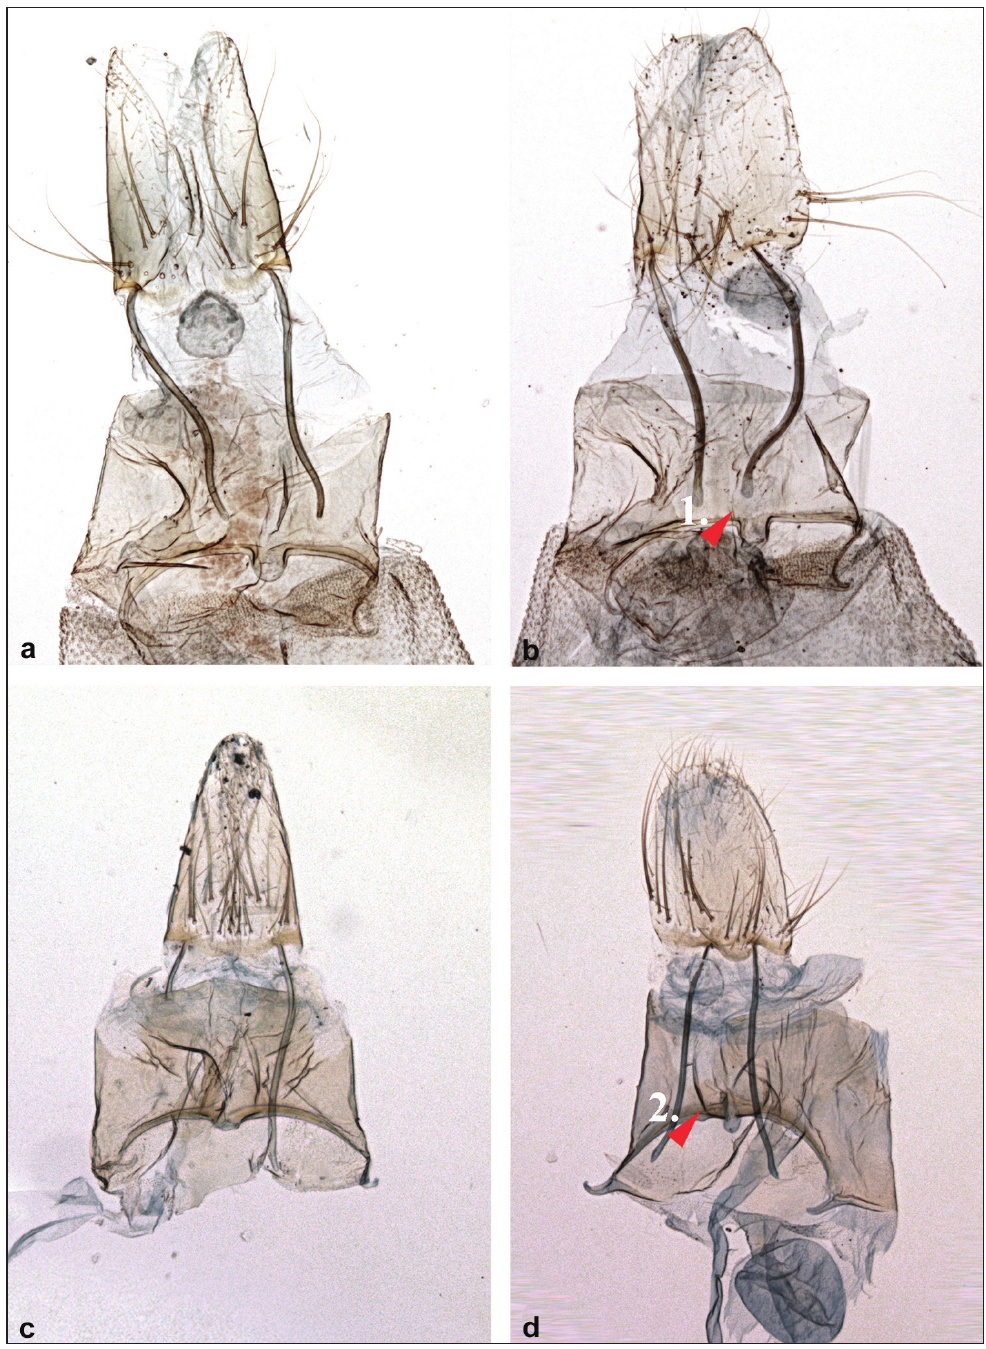
Figure 9. Anarsia female genitalia. a, b. A. innoxiella sp. n. (KG3368, KG3360); c, d. A. lineatella (KG3335, KG3341). 1. ridges absent; 2. ridges